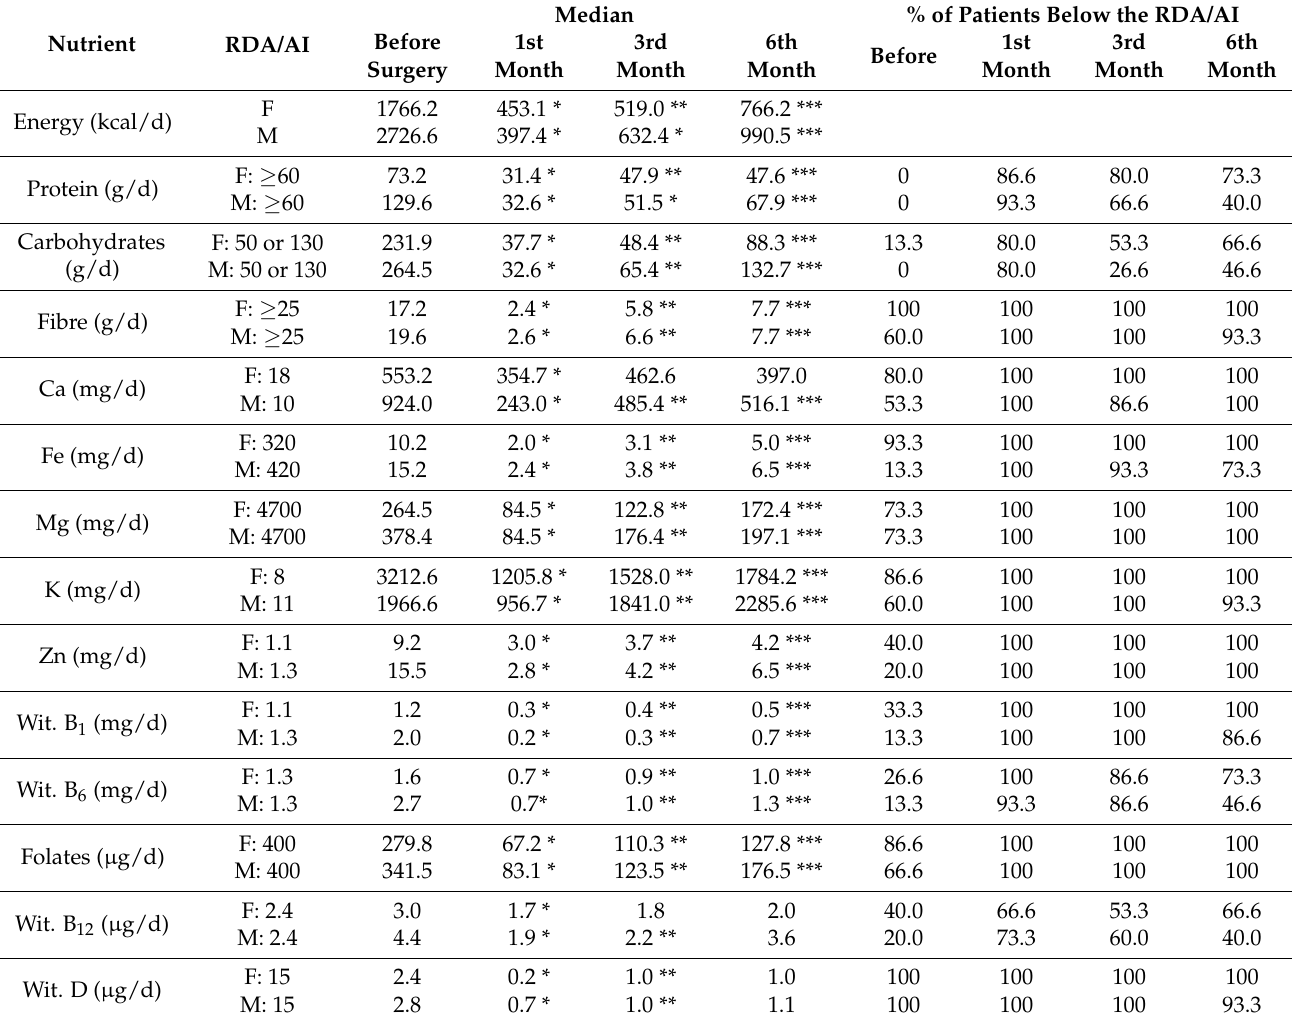
Table 3. Energetic value of the diet and selected nutrient intake before, 1, 3, and 6 months after LSG in the group of women and men and percentage of patients below the